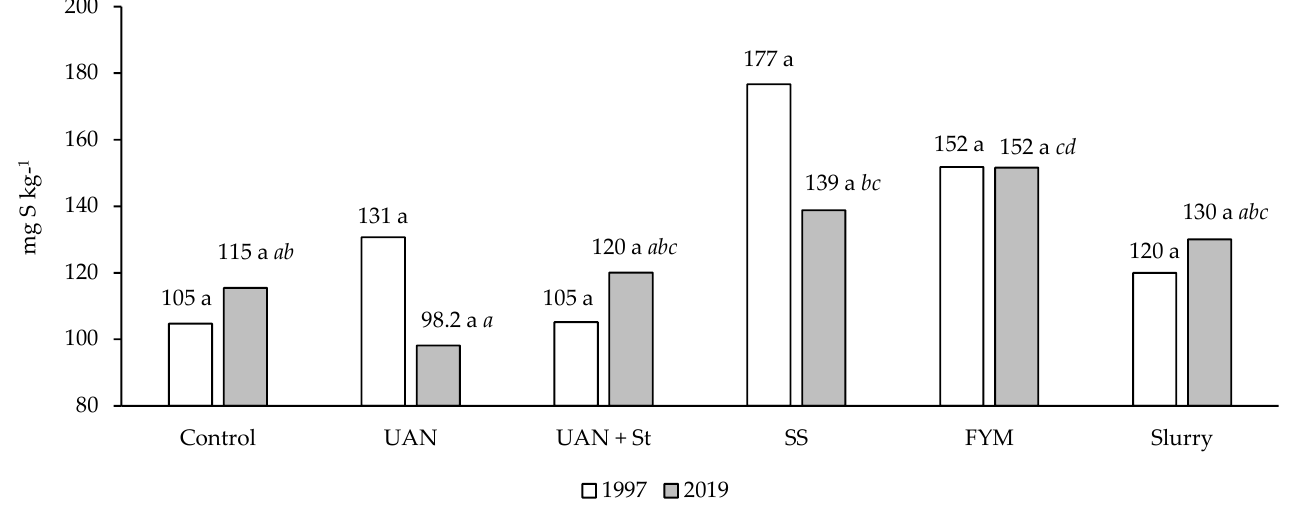
Figure 9. Content of pseudo-total sulfur (S pt ) fraction in the subsoil in 1997 and 2019; the different standard letters describe statistically significant differences between years. The different italic letters (for 2019) describe significant differences between treatments. Tukey HSD test ( p < 0.05), ( n = 4).